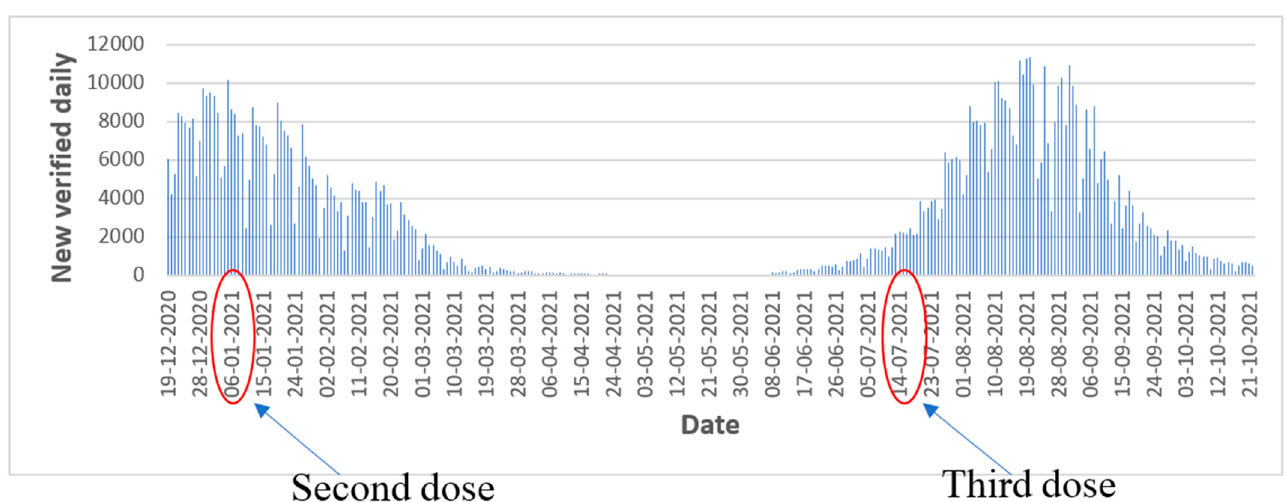
Figure 7. New daily cases.